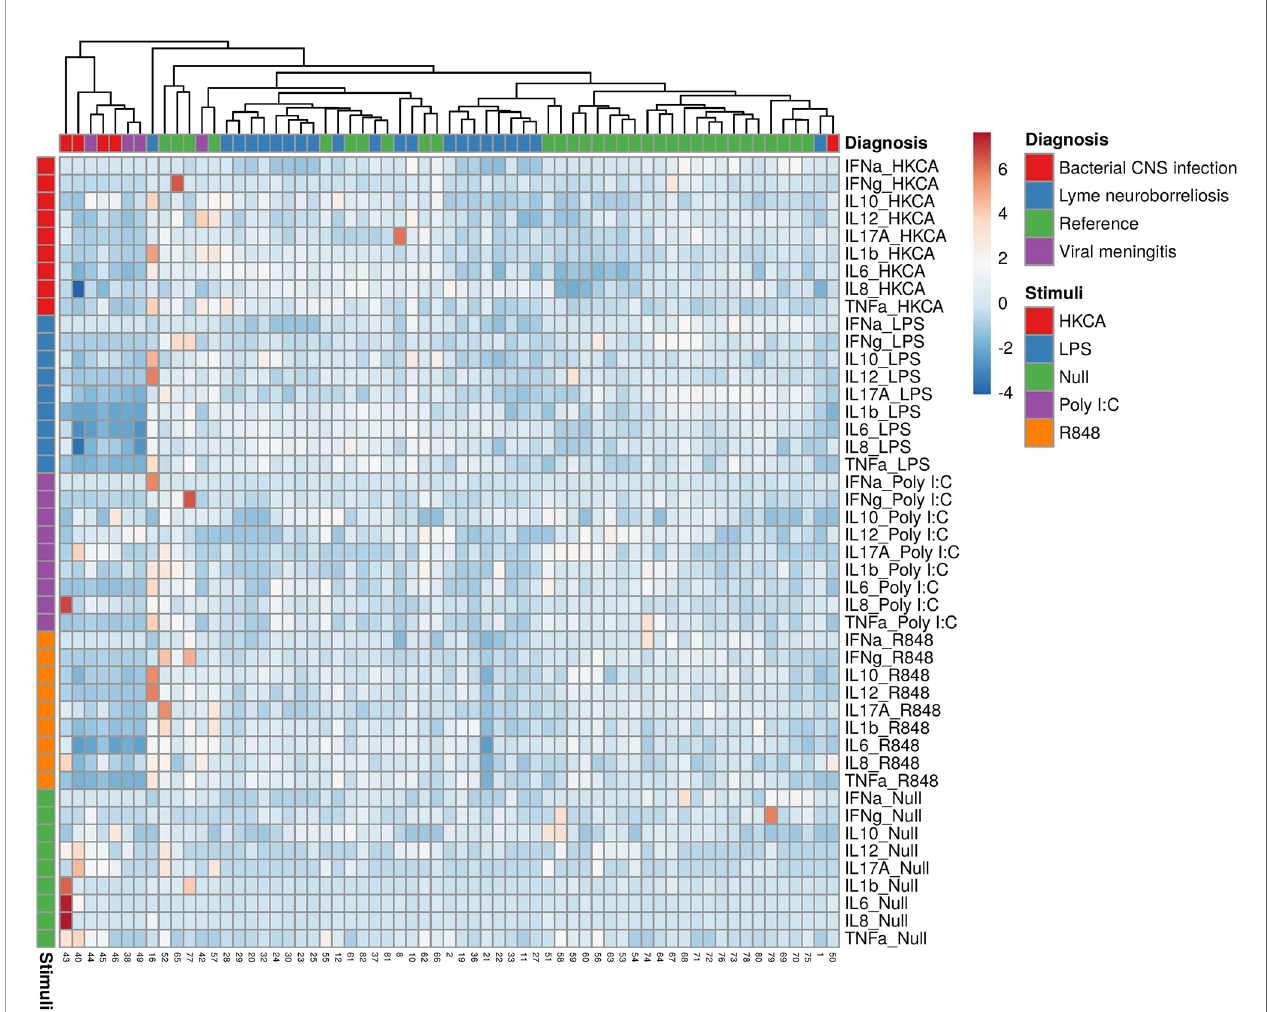
FIGURE 3 | Heatmap of individual cytokine response signatures in blood from patients with LNB (blue), bacterial CNS infections (red), viral meningitis (purple) and references (green). The stimulations are divided and shown horizontally, HKCA (red), LPS (blue), PolyI:C (purple), R848 (orange) and Null (green). The individual response is shown in vertical columns and every square represent the cytokine response for the given stimulation. Column (diagnosis) dendrograms were drawn based on hierarchical clustering analysis using the complete agglomeration method on Euclidian distance matrices and Ward